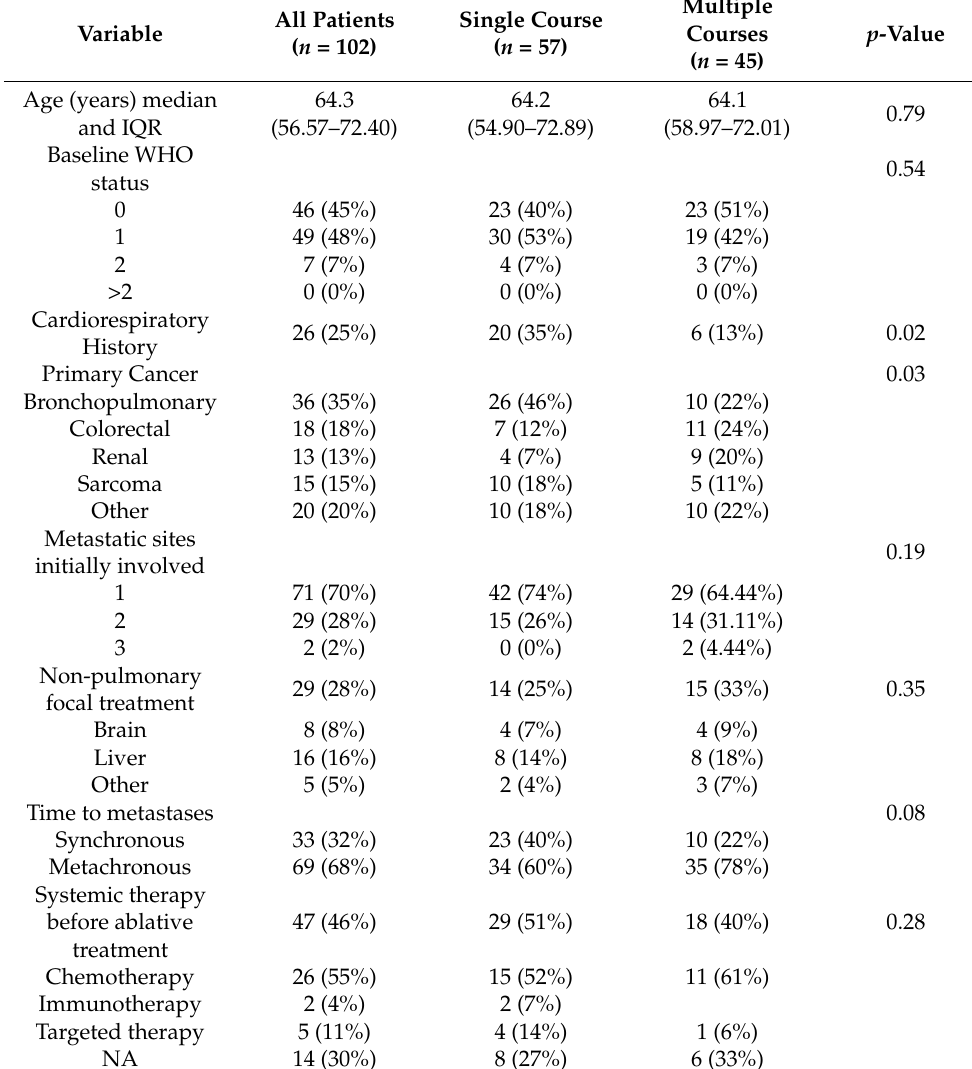
Table 1. Patients’